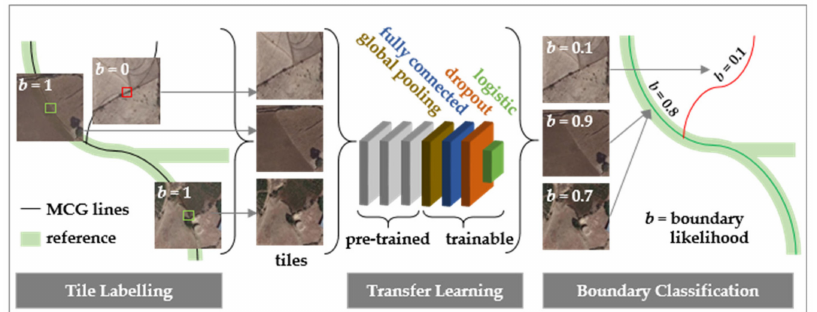
Figure 5. Boundary line classification based on Convolutional Neural Networks (CNNs) to derive boundary likelihoods for MCG